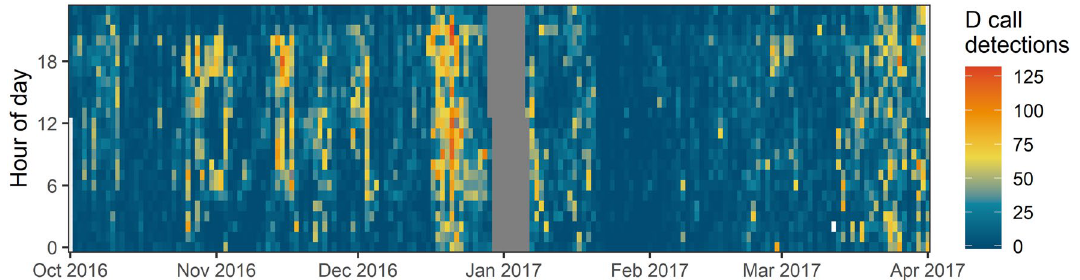
Figure 2. Heatmap showing the number of D call detections per hour at the MARU2 hydrophone between 1 October 2016 and 31 March 2017. Note pulsed increases in D call